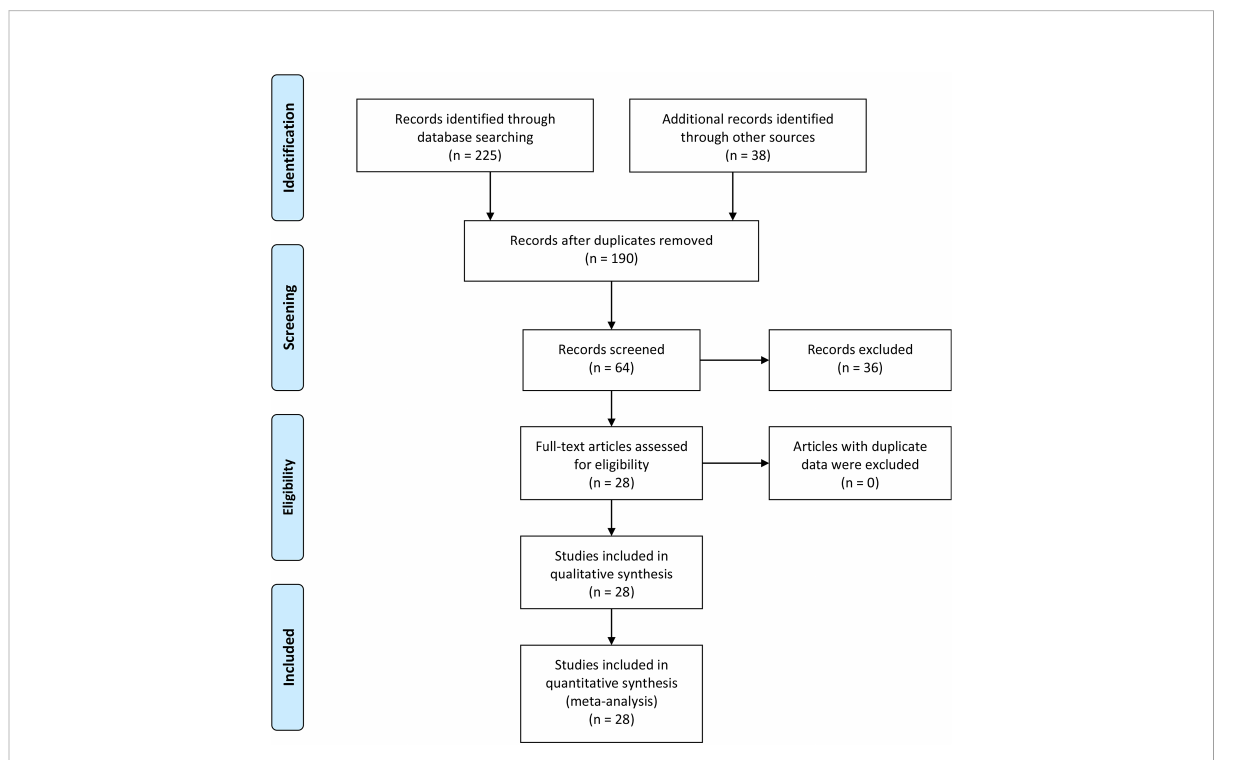
FIGURE 1 Flow chart of eligible studies selection